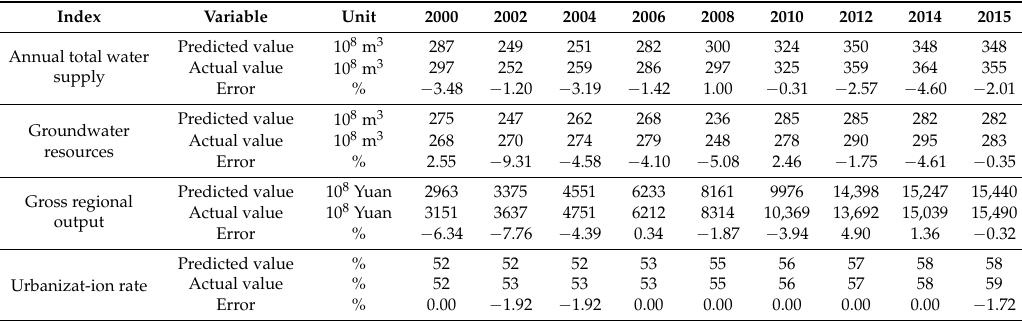
Table 1. The model verification results using historical